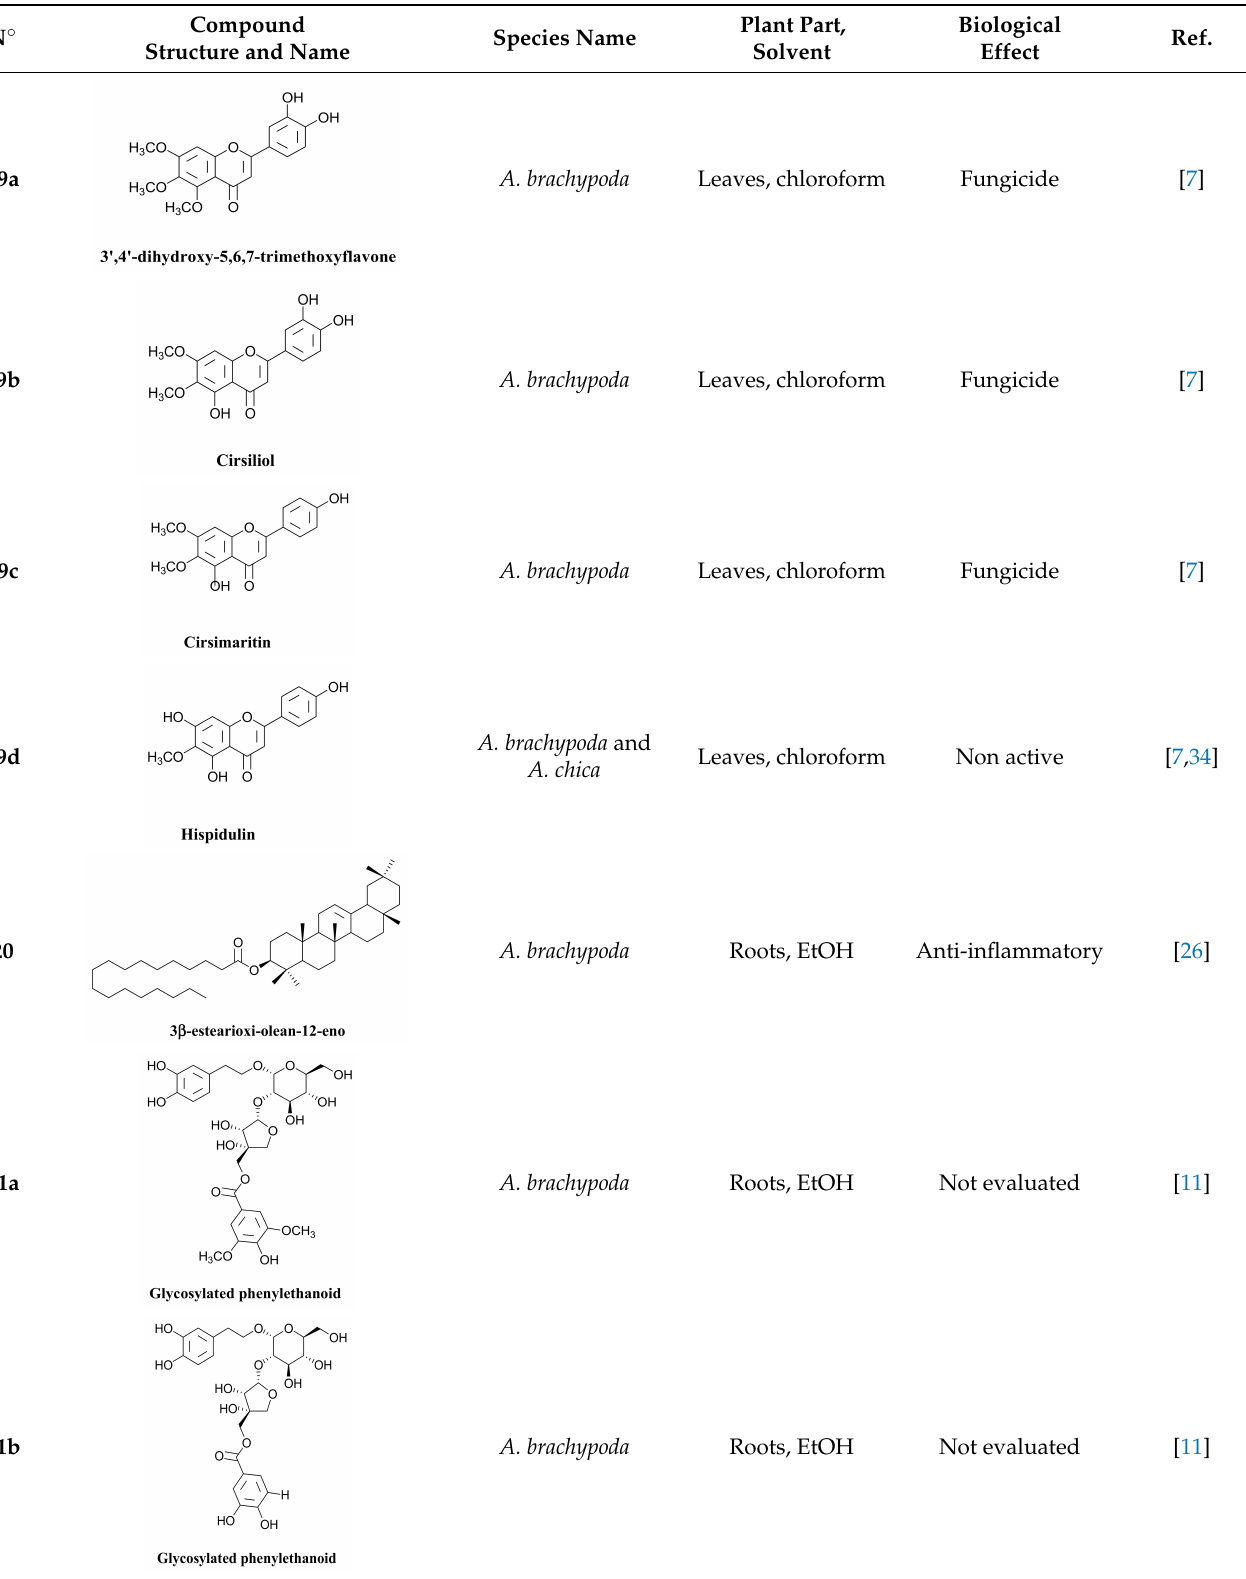
Table 5. Structure and bio-pharmacological properties of isolated compounds from A. brachypoda